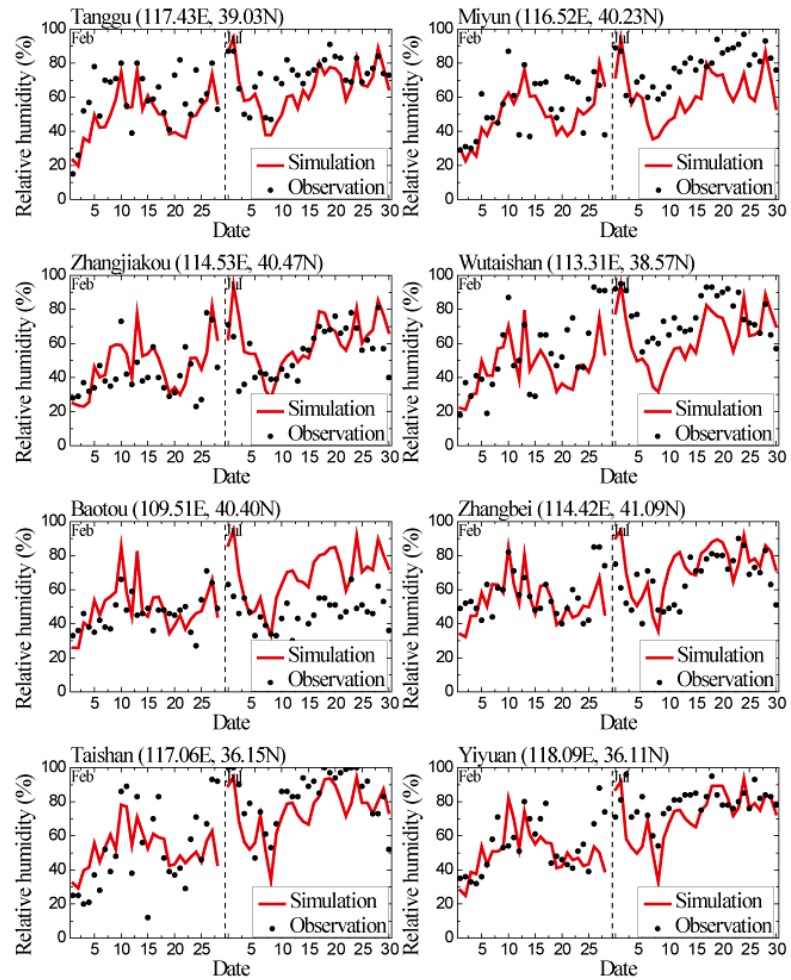
Figure 3. Same as Fig. 2 but for relative humidity